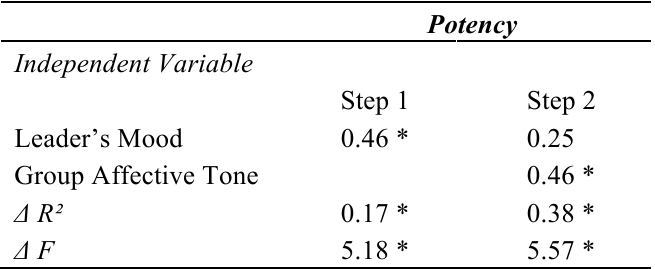
Table 4. Mediation effect of group affective tone in the leader’s mood and potency